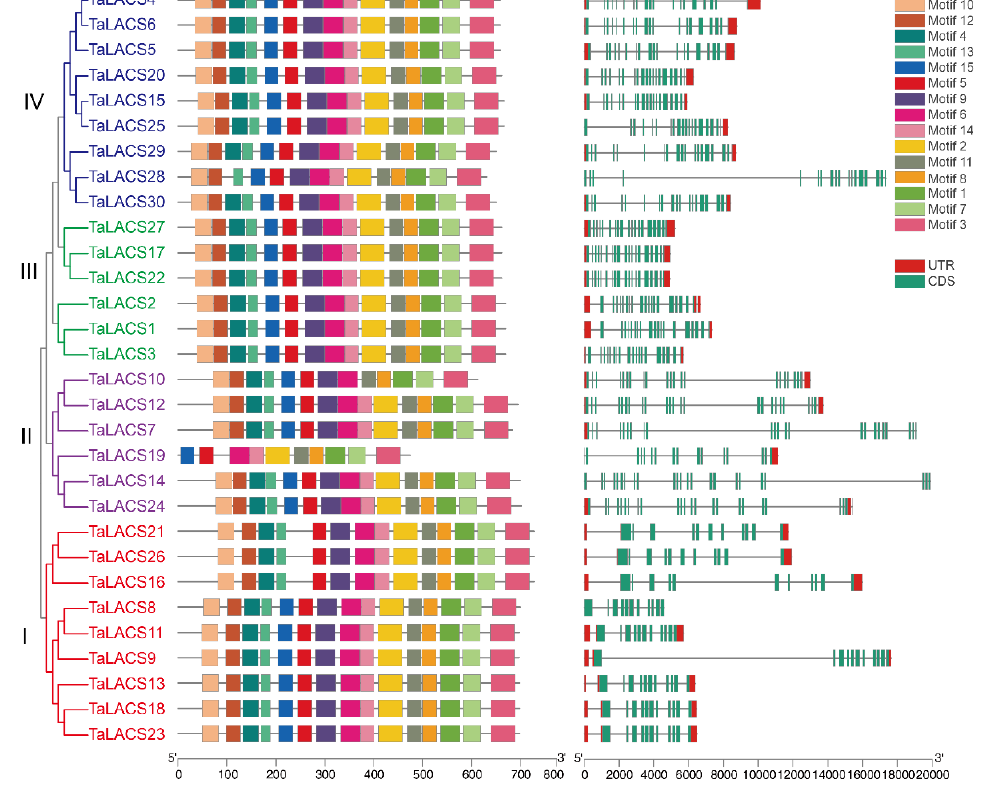
Figure 2. Phylogenetic relationship, conserved motif, and gene structure analysis of TaLACS genes. ( a ) Phylogenetic tree of wheat LACS proteins. ( b ) Conserved motifs of wheat LACS proteins. ( c ). Exon-intron structures of TaLACS genes. Fifteen conserved motifs are shown in different colored boxes, as indicated on the right of the figure. Green boxes in ( c ) represent exons, black lines represent introns, and the upstream/downstream regions of TaLACS genes are represented by red boxes.